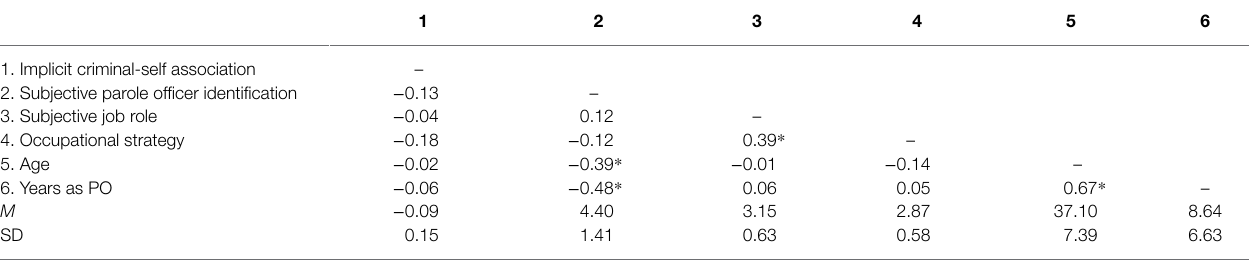
TABLE 2 | Zero-order correlations and descriptives for all participants ( N = 84).